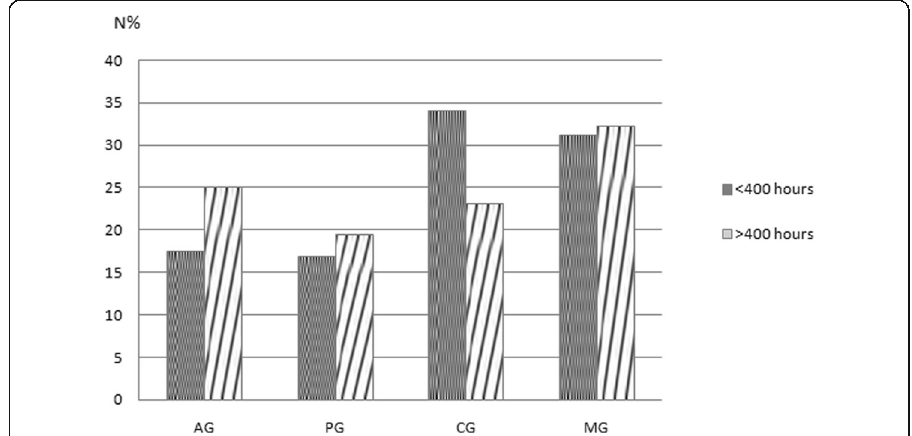
Fig. 2 Training time differences in cluster composition of the four